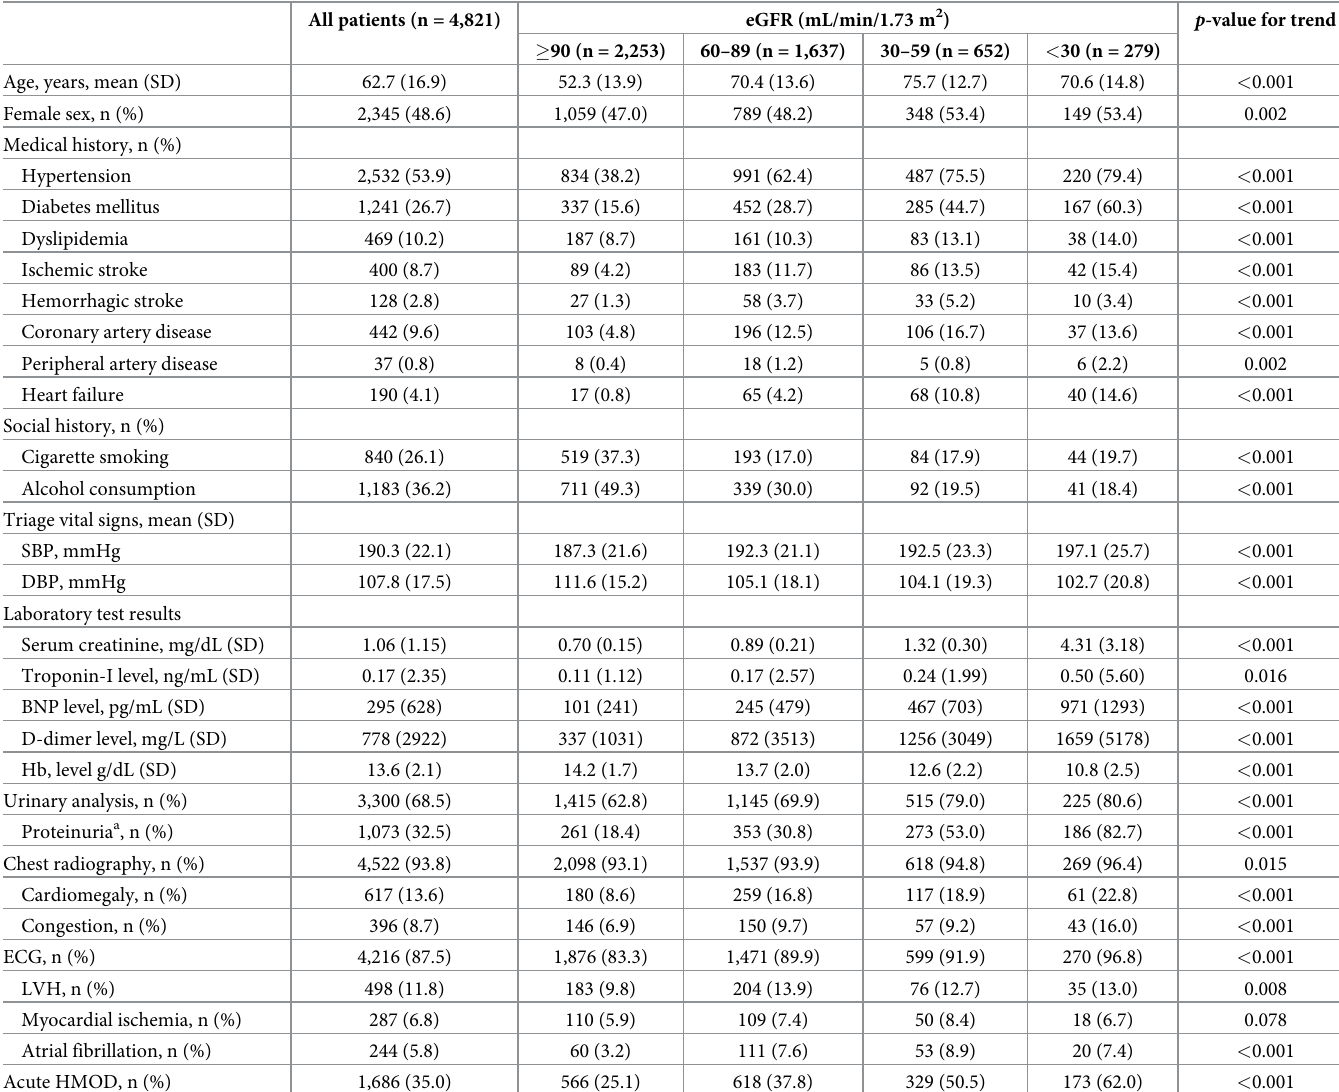
Table 1. Baseline